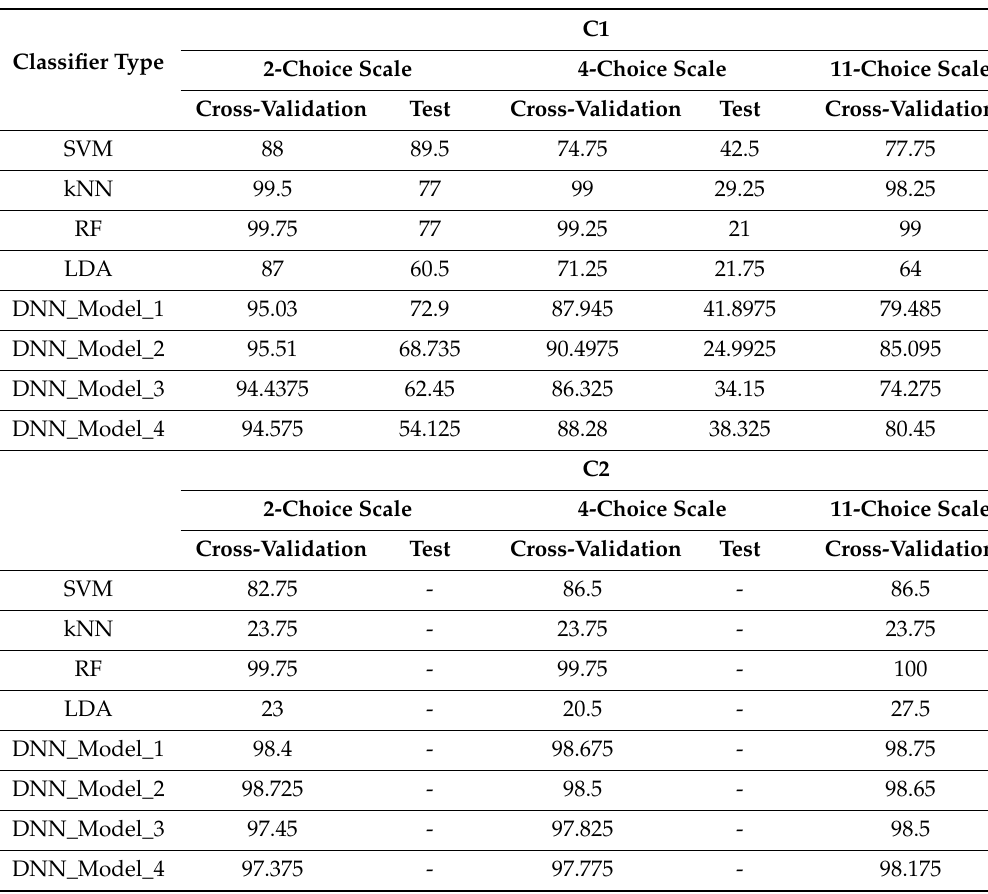
Maximum cross-validation accuracy and test (validation) accuracy (in %) for the player-dependent modality, without SFS feature